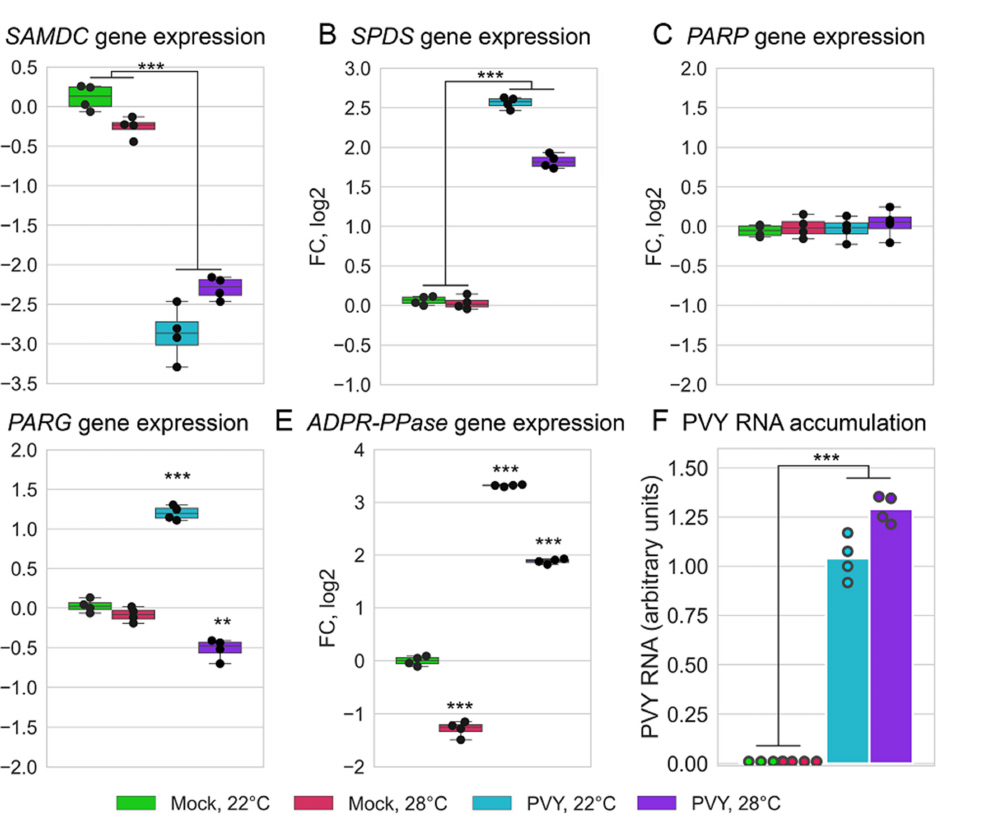
Figure 6. The dynamic expression patterns of important genes associated with MTC ( SAMSDC, SPDS ) and PARylation processes ( PARP, PARG and ADPR-PPase) ( A – E ) and PVY RNA accumulation ( F ) anal- ysed by RT-qPCR in systemically infected leaves of Chicago plants at 22 or 28 ◦ C at 8 dpi, as shown. SAMDC, adenosylmethionine decarboxylase (Soltu.DM.02G030190.1); SPDS, spermidine synthase (Soltu.DM. DM.06G014450.1); PARG, poly(ADP-ribose) glycohydrolase (Soltu.DM.12G003820.1); PARP, Poly(ADP-ribose) polymerase (Soltu.DM.03G032200.1); ADPR-PPase, ADP-ribose pyrophos- phatases (Soltu.DM.08G000850.1). Analysis of variance and Tukey’s HSD post hoc tests were per- formed on the RT-qPCR data. ** p < 0.01, *** p <